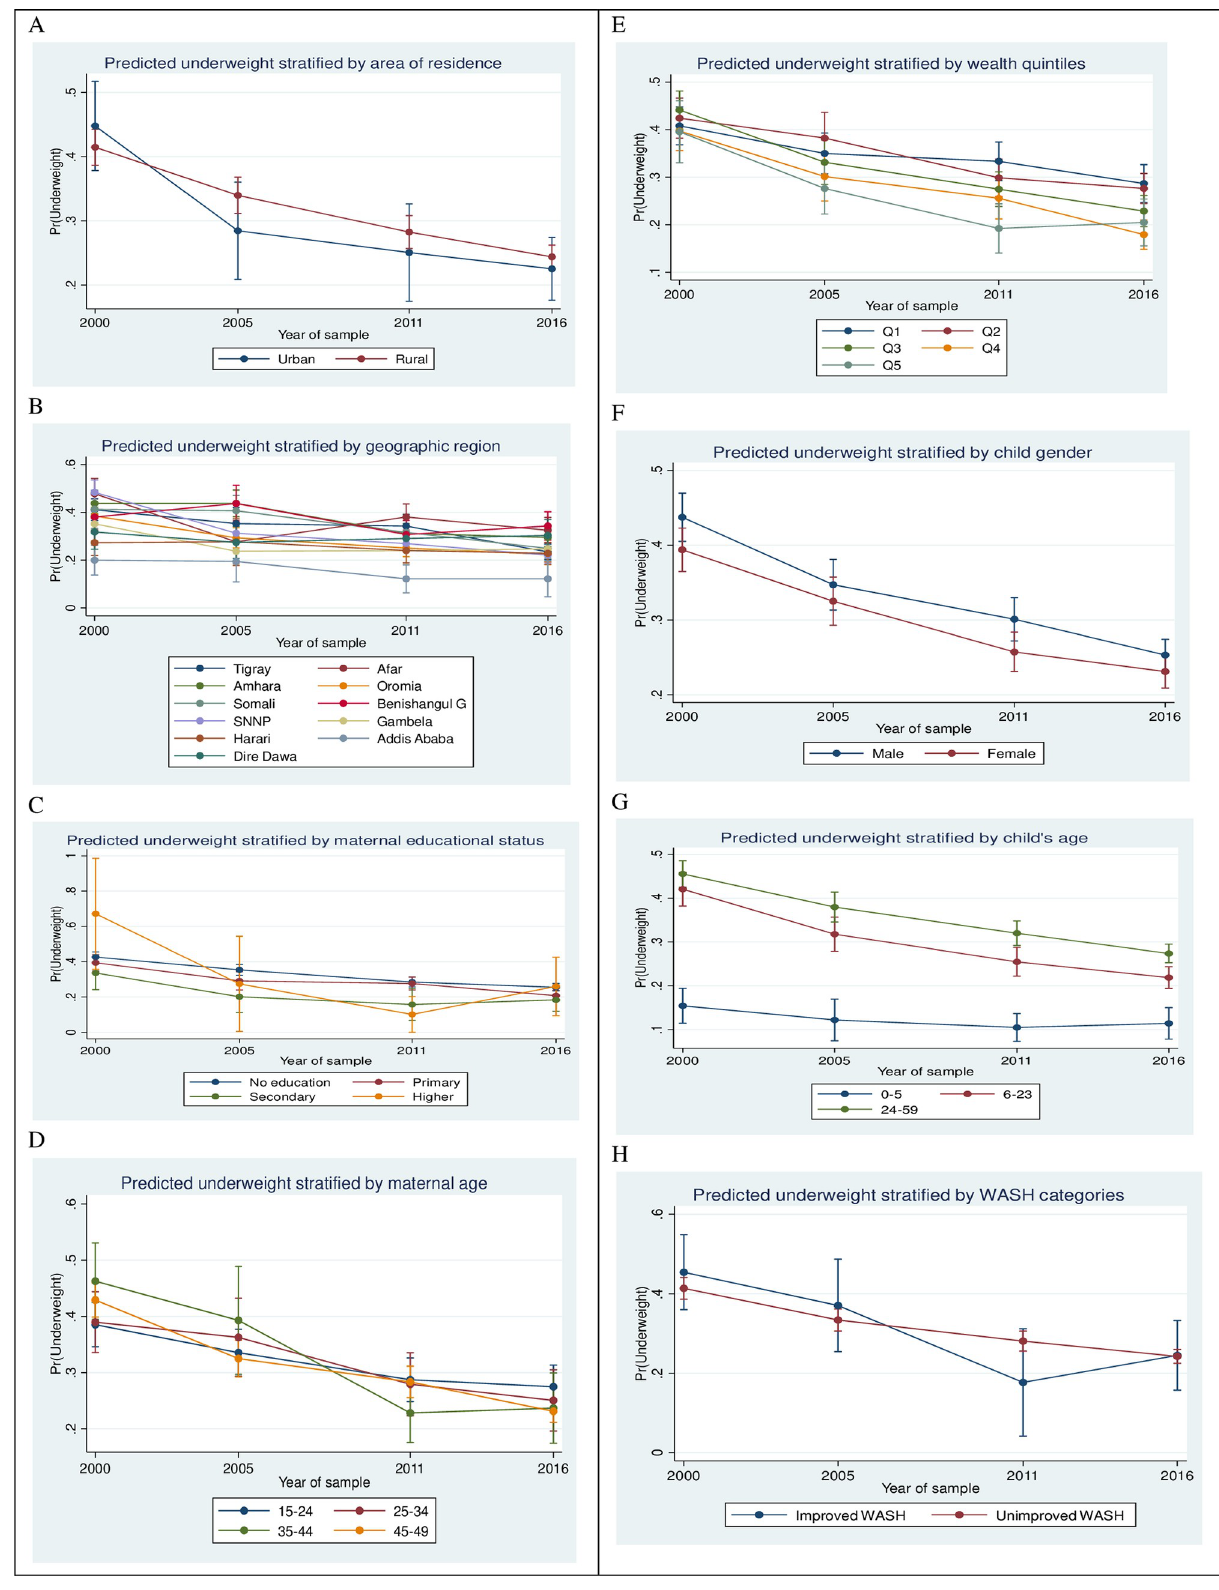
Fig 3. Adjusted predicted probabilities of being underweight by key predictors among under-5 children in Ethiopia, EDHS 2000 to 2016. https://doi.org/10.1371/journal.pone.0254768.g003 PLOS ONE | https://doi.org/10.1371/journal.pone.0254768 August 5,